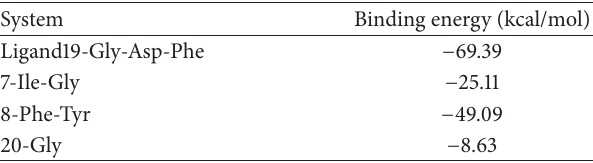
Table 6: The binding energies are calculated at M06/6-31g(d) level of theory in gas phase for the ligand-amino acid complexes.